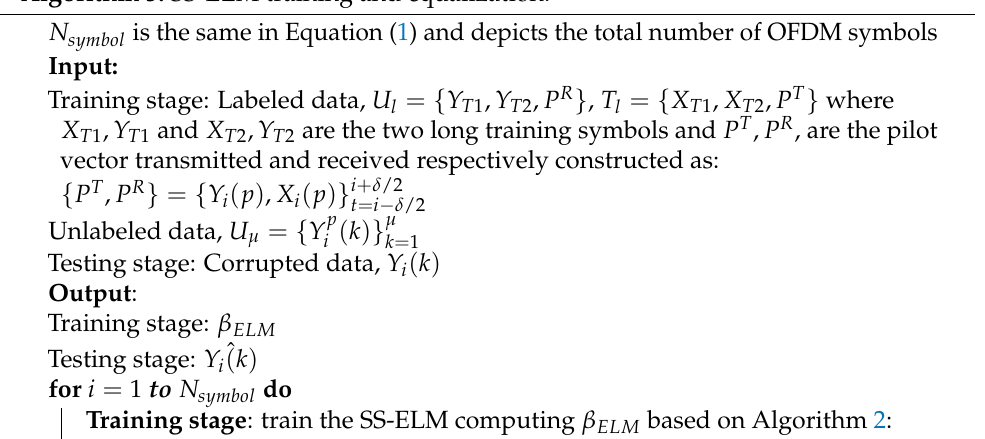
Algorithm 3: SS-ELM training and